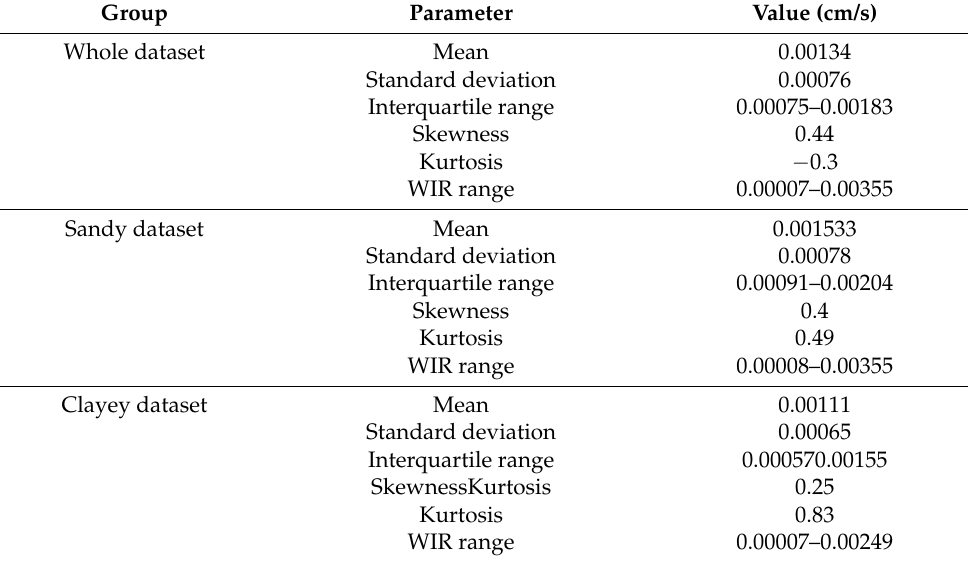
Table 2. Dispersion statistics of the studied